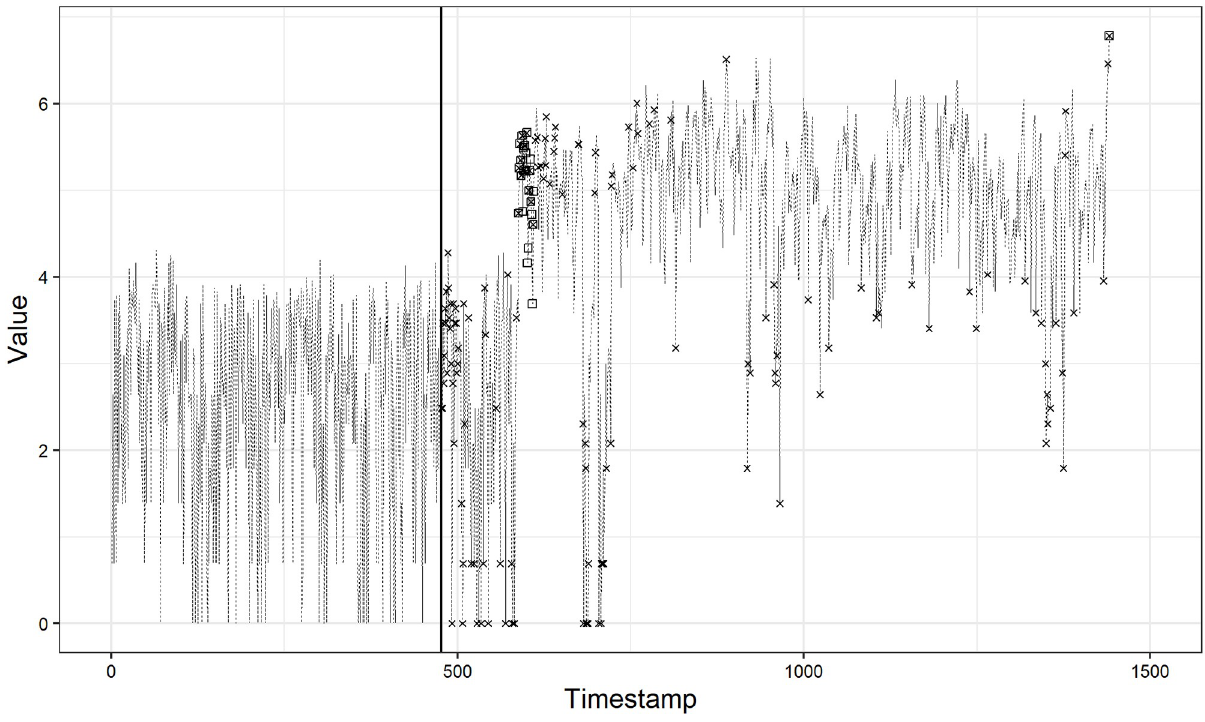
Fig 5. Anomaly detection result on time series No.61.